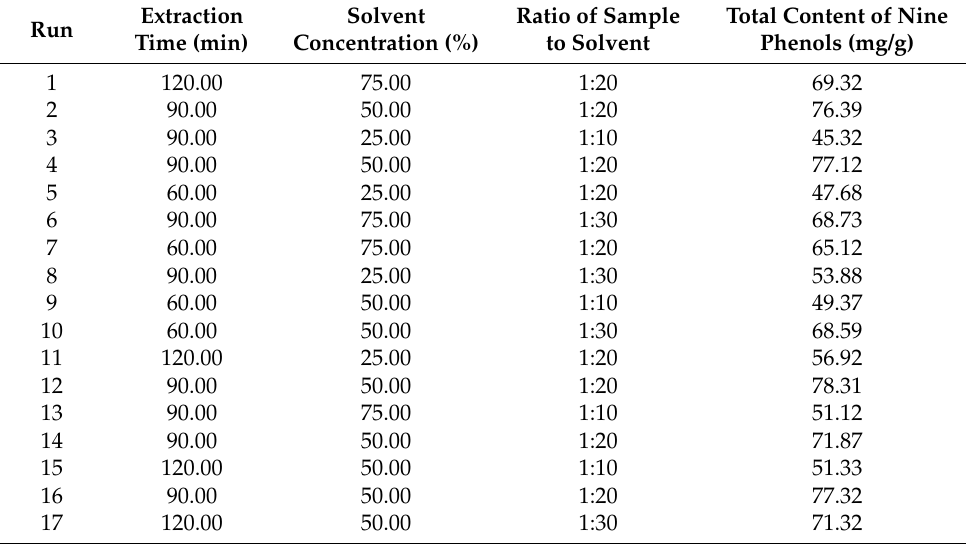
Table 1. Numerical values of response obtained under the designed conditions taking the sample of No. 5 for example, and the contents of each phenol determined by HPLC as response values. (n = 3) (Supplementary